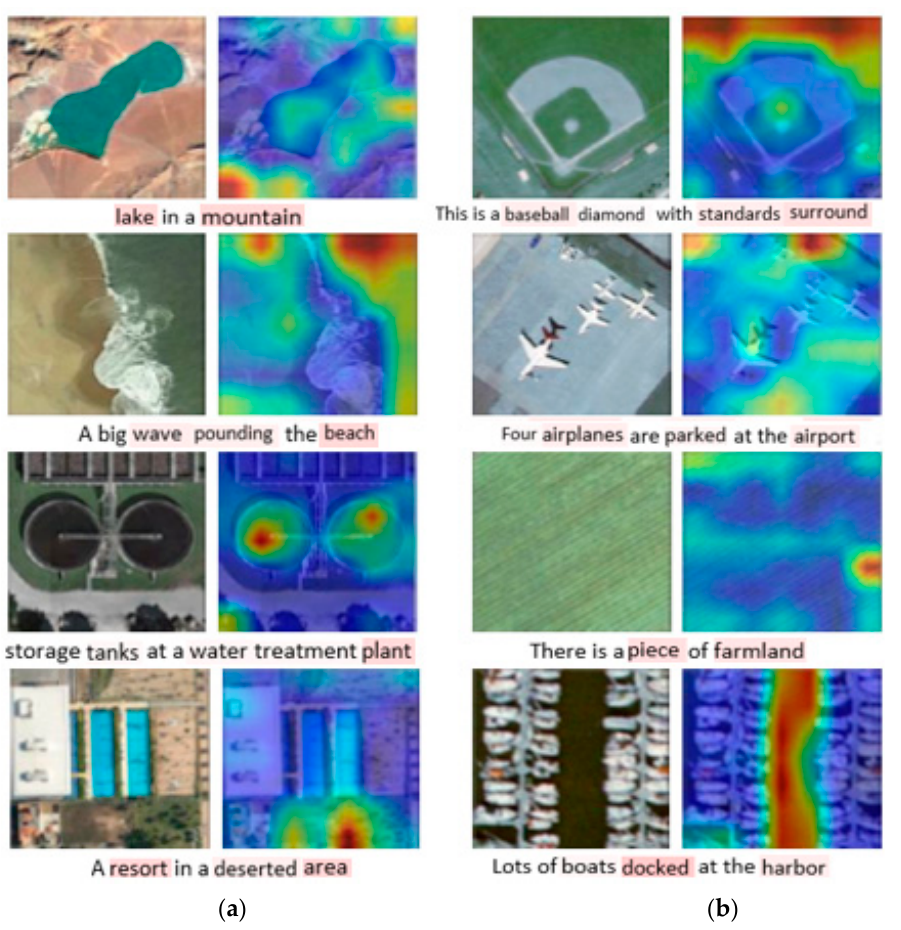
Figure 4. Examples for original image its corresponding attention (image and text) for dataset: ( a ) TextRS and ( b ) Merced dataset. Table 4. Average mR retrieval results for TextRS, Merced, and Sydney datasets based on three different configurations: Config. 1: models pre-trained on text–image matching; Config. 2: models pre-trained in a self-supervised mode; Config. 3: models pre-trained in a supervised